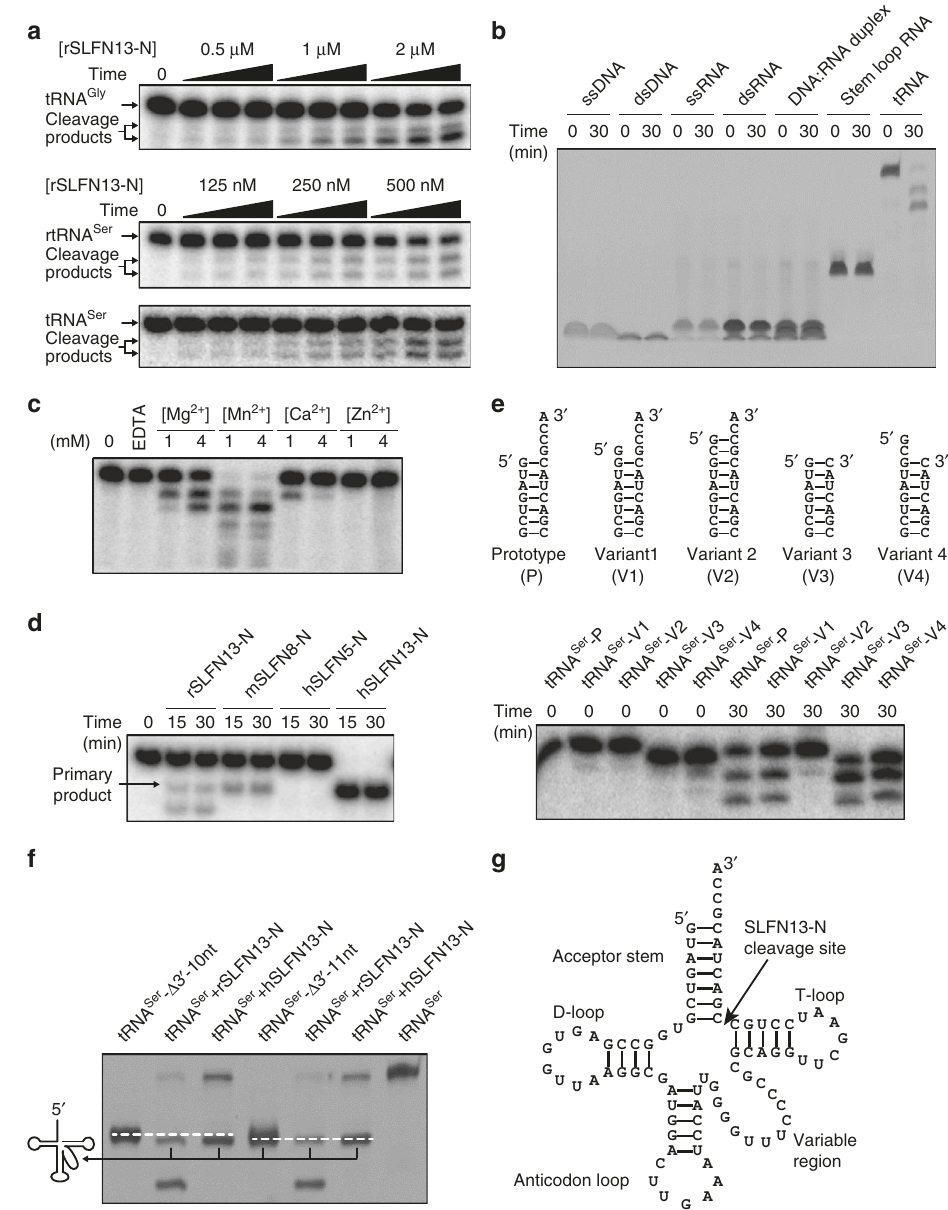
Fig. 2 Endoribonuclease activity of SLFN13-N. a Dose-dependent and time-dependent tRNA digestion by rSLFN13-N in the presence of Mg 2 + . rSLFN13 1 – 353 of indicated concentrations were incubated with [ α - 32 P]-labelled human tRNA Gly , human tRNA Ser or rat tRNA Ser (rtRNA Ser ) for 5, 15 and 30 min. b rSLFN13-N preferably cleaves tRNA. ssDNA/ssRNA single-stranded DNA/RNA, dsDNA/dsRNA double-stranded DNA/RNA. c Analysis of divalent cations as cofactor of rSLFN13-N for tRNA digestion. 500 nM rSLFN13 1 – 353 was incubated with [ α - 32 P]-labelled tRNA Ser for 30 min. Four different divalent cations were individually tested. d Cleavage assay for different SLFN-N proteins. 250 nM rSLFN13 1 – 353 , mSLFN8 1 – 359 , hSLFN13 1 – 355 or hSLFN5 12 – 334 was individually incubated with [ α - 32 P]-labelled tRNA Ser . Note that hSLFN13-N shows highest nucleolytic ef fi ciency over human tRNA Ser . e Cleavage assay for rSLFN13-N on acceptor stem variants. Modi fi cations of the variants are speci fi ed. 500 nM rSLFN13 1 – 353 was used in each reaction. f tRNA cleavage pattern of SLFN13- N. The primary cleavage products from tRNA Ser by rSLFN13 1 – 353 and hSLFN13 1 – 355 were compared with in vitro transcribed tRNA Ser that lacks 3 ′ -terminal 10 nt (tRNA Ser − 3 ′ - Δ 10 nt) or 11 nt (tRNA Ser − 3 ′ - Δ 11 nt), and portrayed to the left. The migration of two truncated tRNA Ser markers is indicated by dashes lines. g Proposed primary cleavage site of SLFN13-N. The sequence of human tRNA Ser is used here as